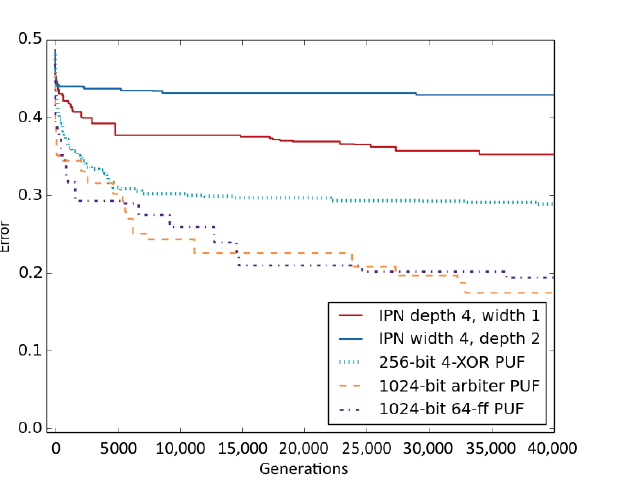
Figure 4. Evolution strategies attack result using 30,000 challenge-response pair (CRP) training set on five PUF-based systems. Error vs. iterations.